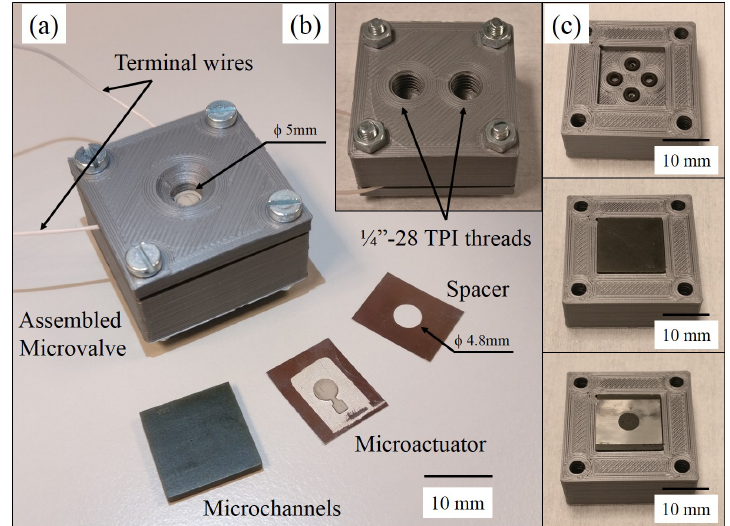
0.5mm diameter. ( b ) Bottom view of the holder ( c ) First step: O-rings placed in O-ring